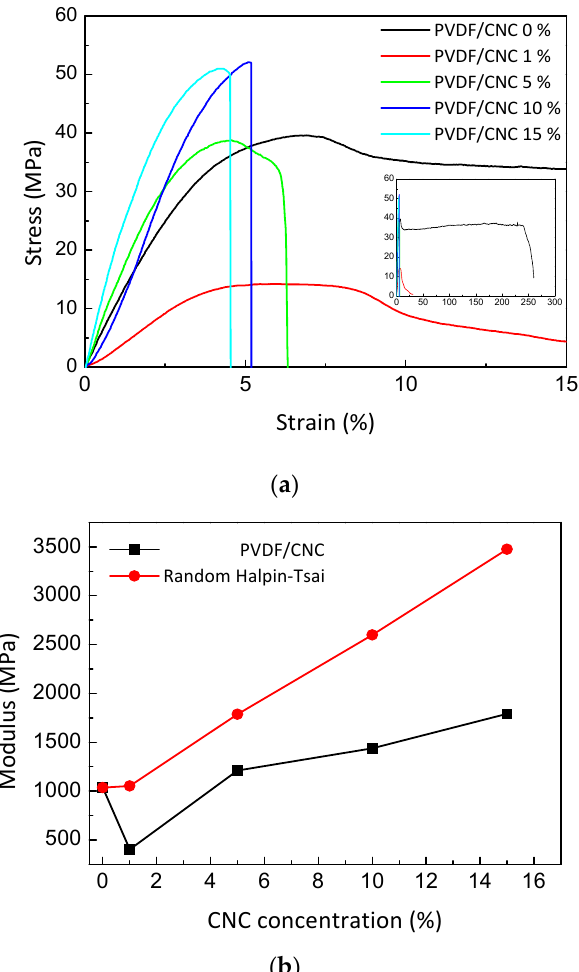
Figure 5. ( a ) Stress–strain tensile curves of the PVDF/CNC nanocomposites and ( b ) experimental data and fitting results according to the modified Halpin–Tsai model.